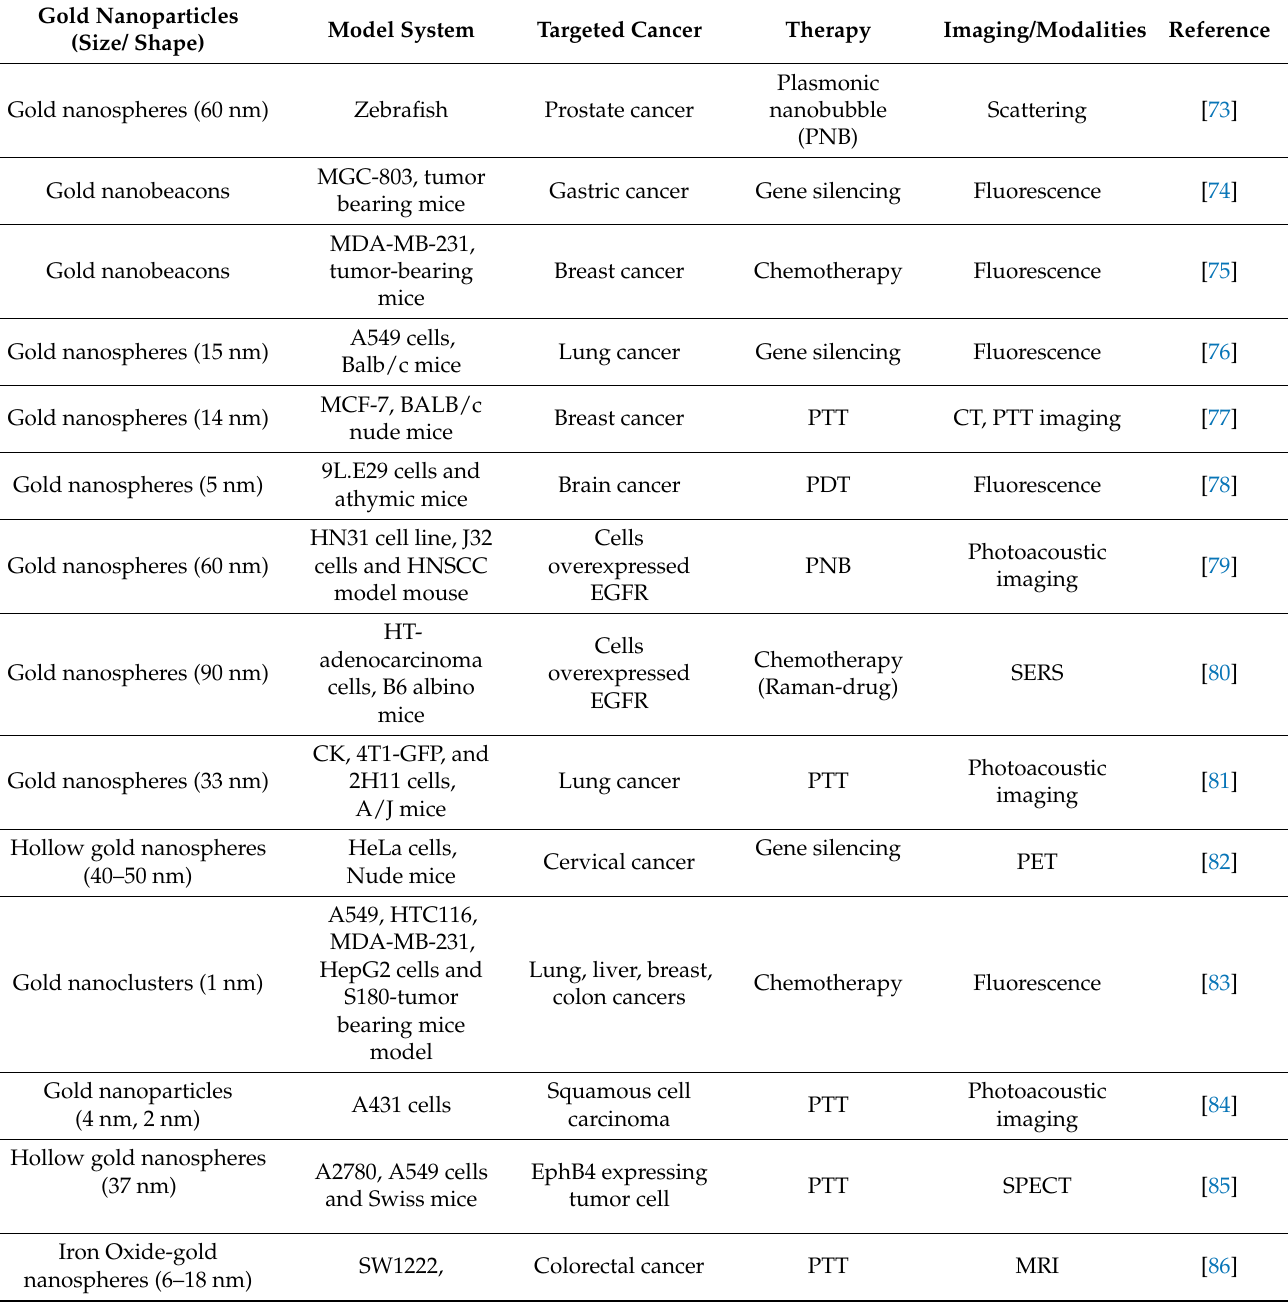
Table 1. Compilation of several reported studies on using isotropic gold nanoparticles in cancer nanotheranostics and their respective in vitro/in vivo safety